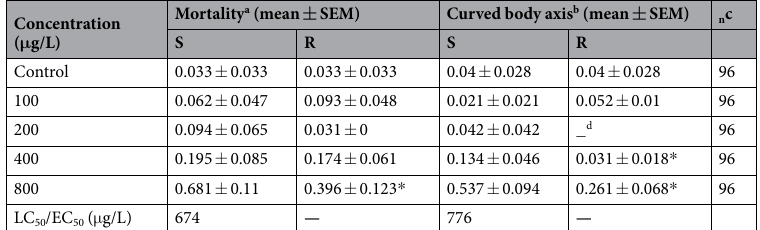
— Table 1. Enantioselective effects of fipronil enantiomers (R, S) on the mortality and curved body axis of zebrafish larvae from 6 hpf to 120 hpf. a Number of mortality of zebrafish larvae over the total number used for statistical analysis. b Number of zebrafish larvae with curved body over the total number used for statistical analysis. c Number of animals used for statistical analysis. d No effects were detectable using the criteria of this study. * Statistically significant difference between the two enantiomers exposed groups at a level of p <